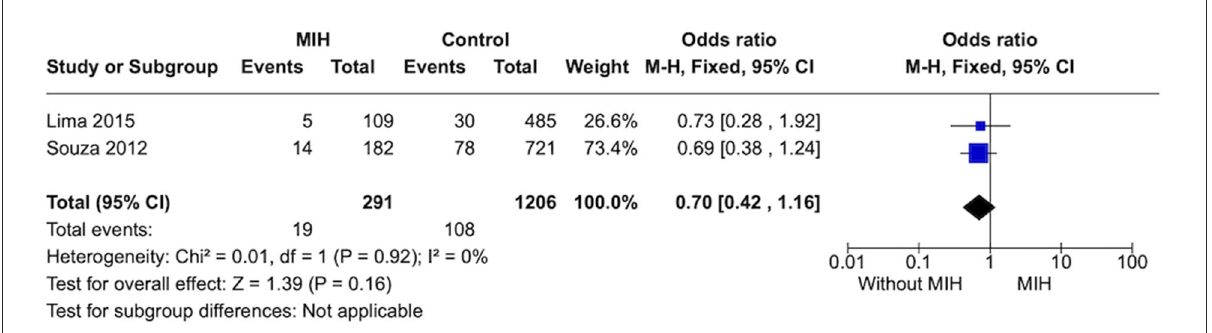
FIGURE6 Forest plot of meta-analysis for the prevalence of rhinitis among subjects with MIH. CI, confidence